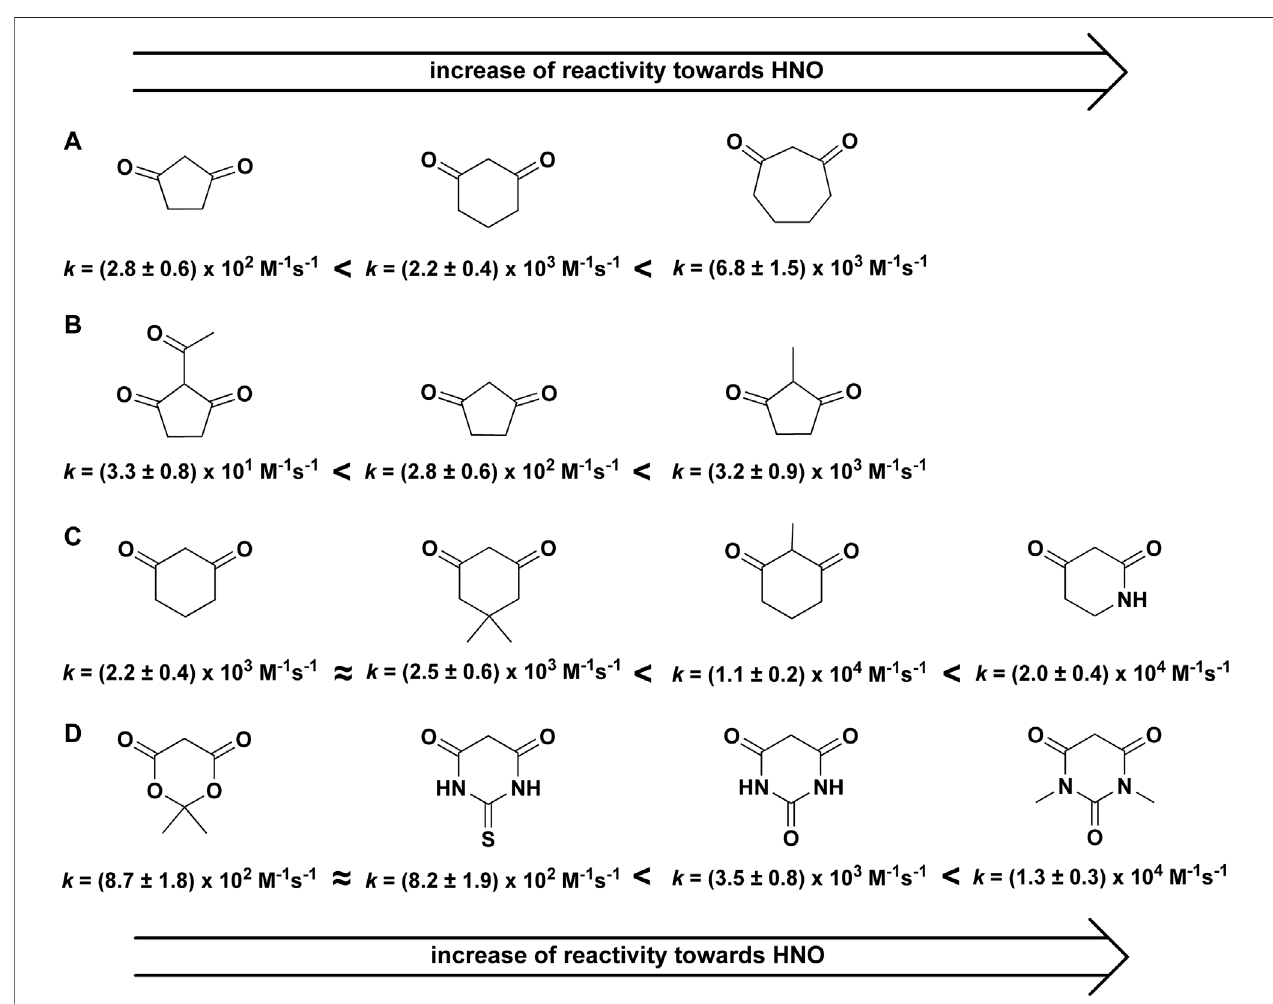
FIGURE 1 | Reactivity of HNO towards cyclic C